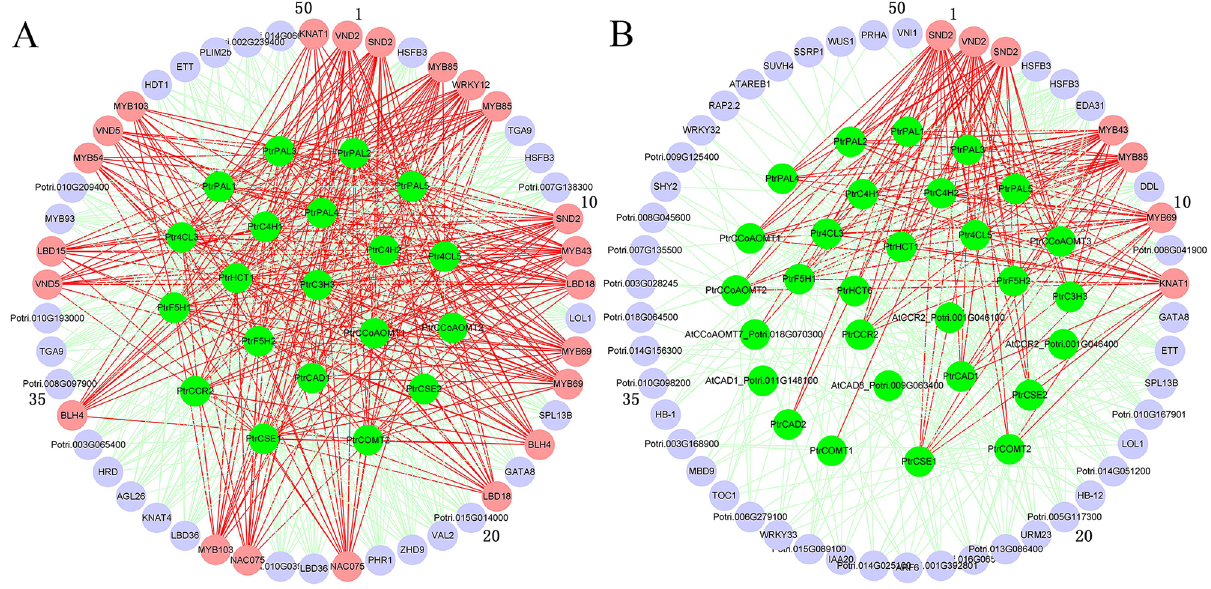
Figure 4. Regulatory network generated by triple-gene mutual interaction (TGMI) ( A ) and sparse partial least squares (SPLS) ( B ) for the Populus trichocarpa lignin biosynthesis pathway using the RNA-seq data generated from developing xylem tissues. The green nodes represent pathway genes. All other nodes are the top 50 transcription factors that have the highest connectivity to pathway genes regardless of their colors. The light coral nodes represent positive known TFs of lignin biosynthesis while the red edges are to show the connections of a true positive known pathway regulator with pathway